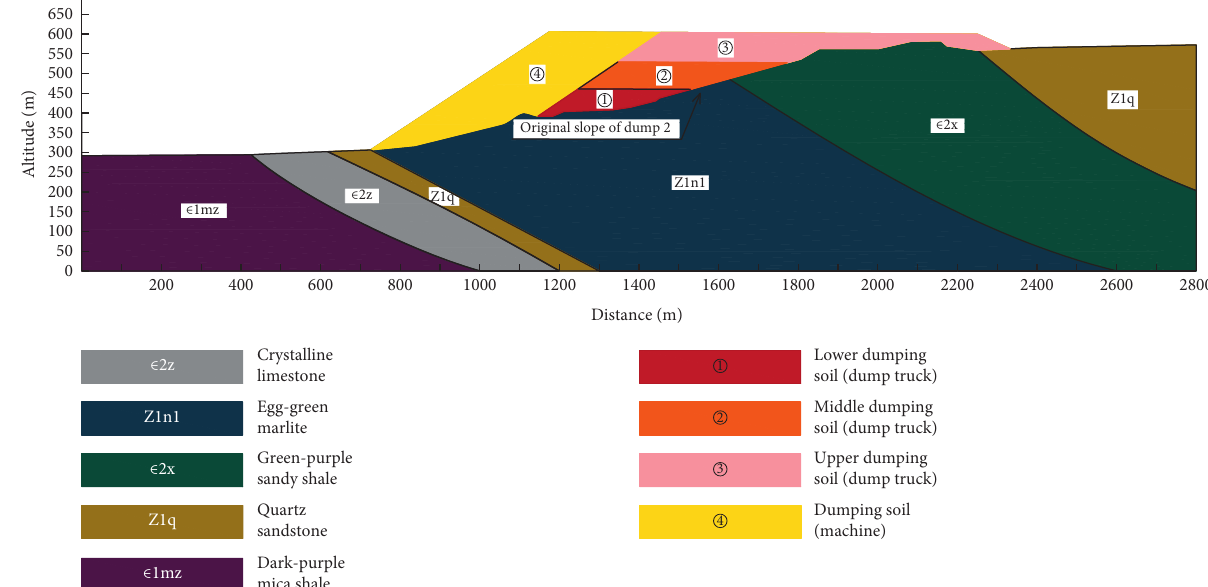
Figure 9: The generalized geological model of section 2-2.